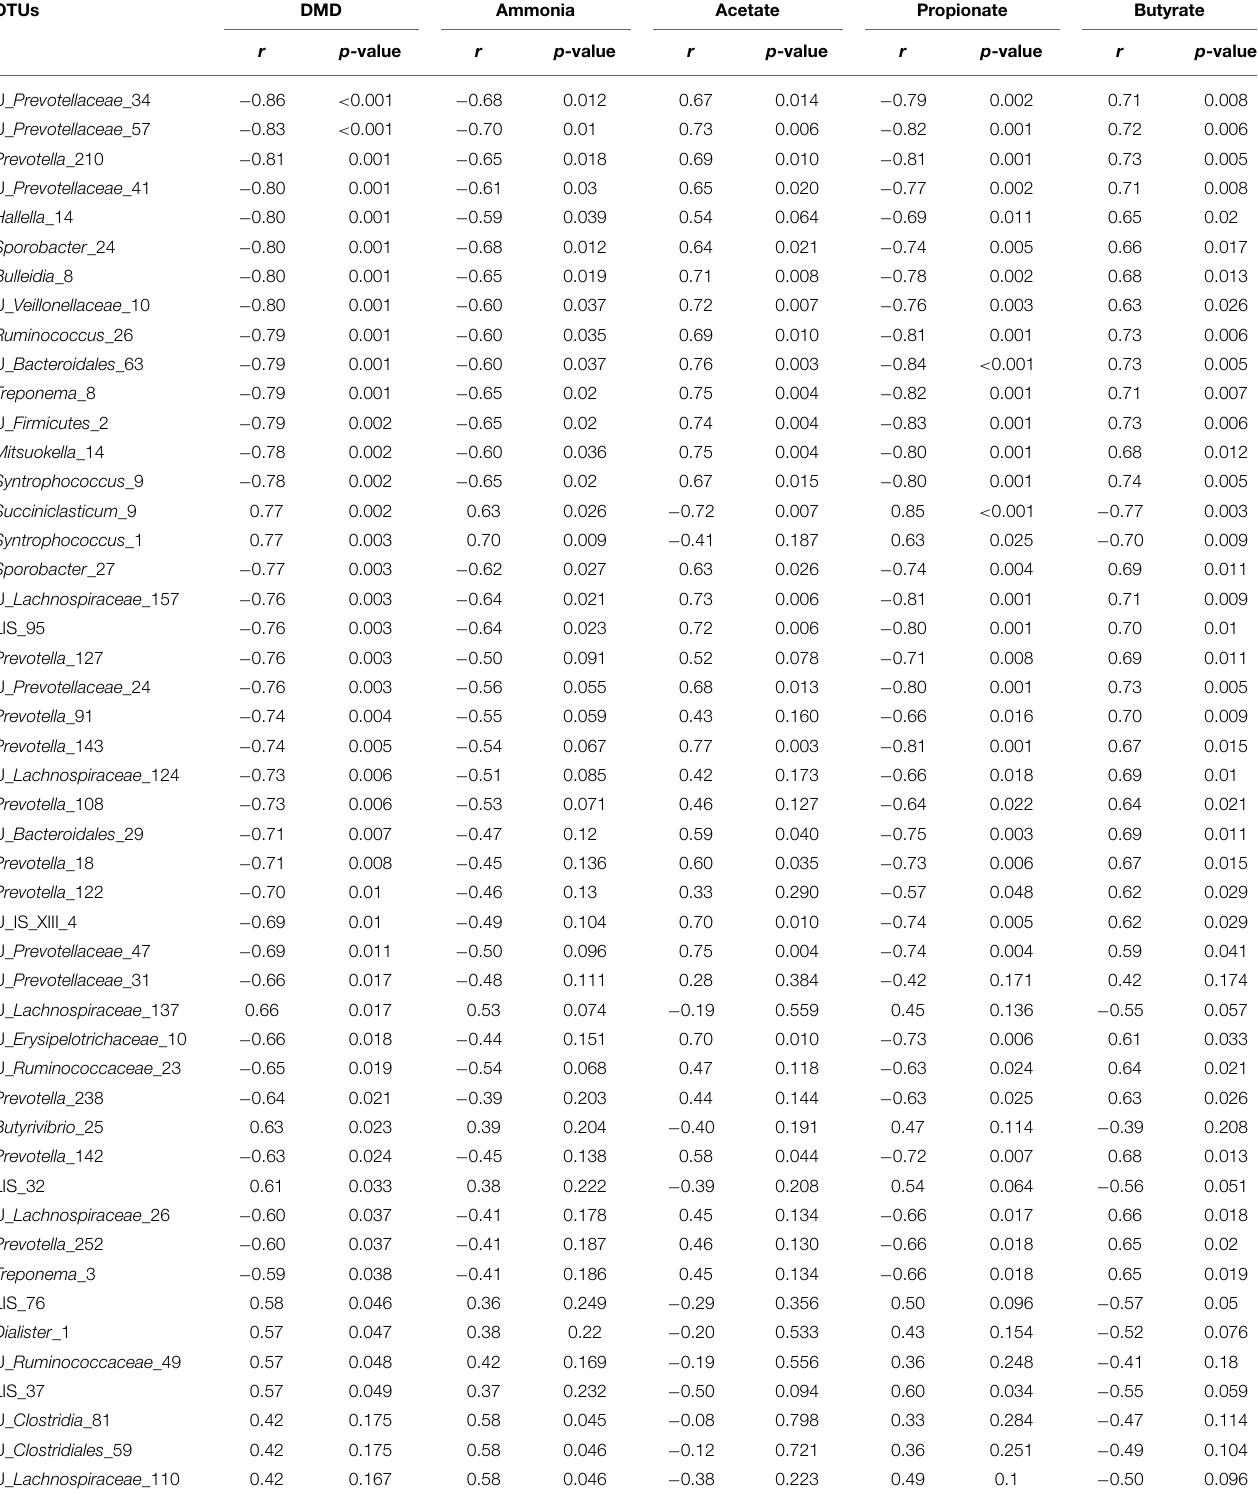
TABLE 4 | Significant ( P ≤ 0 .05) Pearson correlation coefficients ( r ) between relative abundances of operational taxonomic units (OTUs) and some of the rumen fermentation characteristics OTUs DMD Ammonia Acetate Propionate